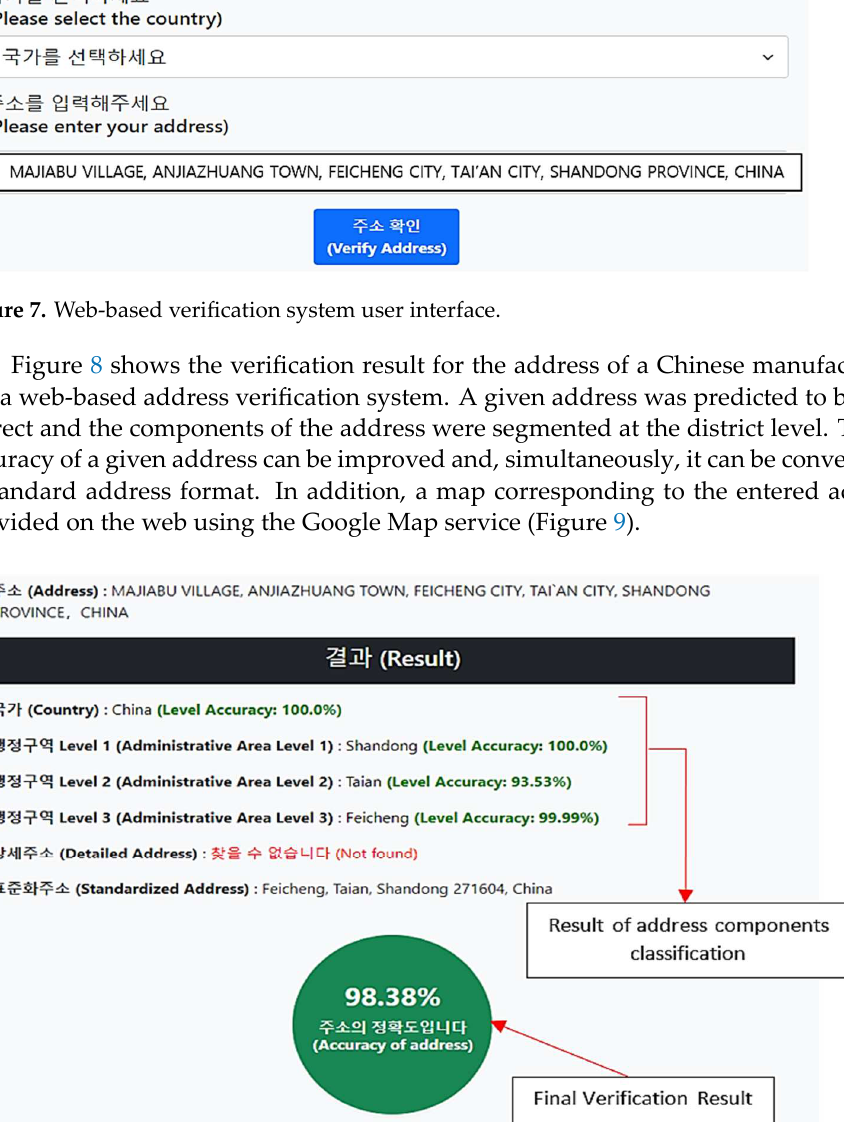
Figure 9. Location for the manufacturer address provided by Google Map service. 5. Discussion Most of the existing studies deal with address verification processes, such as parsing, matching, and standardizing for a specific context or country, but the proposed method in our research is designed to apply to various countries based on deep learning classifi- cation models using each country’s administrative district data. The deep learning model is able to determine the level of administrative districts from a given address string and through this, the accuracy of the given address is calculated and the quality is improved by converting it into a standardized address. In addition, it is able to overcome the limi- tations of existing geocoding services that cannot accurately identify the administrative district level corresponding to the entered address of the manufacturers. Regarding the experimental results, the proposed method is able to verify and eval- uate the manufacturers’ addresses significantly and such tasks have not been completed yet in prior research. Prior studies did not primarily concentrate on categorizing the ad-